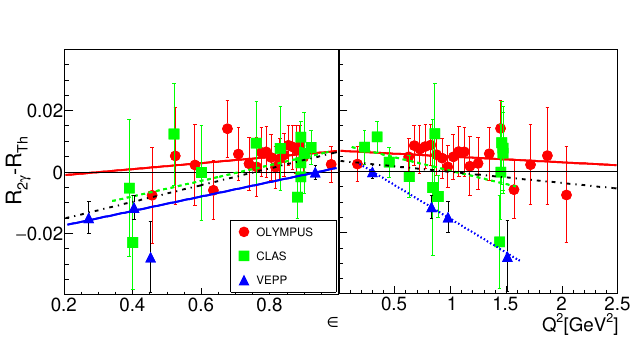
Figure 3. Point to point di ff erence between the calculation from Eq. (7), [38] and the data for the ratio R , with the corresponding linear fits as a function of (cid:15) (left) and Q 2 (right) from OLYMPUS [36] (red circles and red solid line), CLAS [35] (green squares and green dashed line) and VEPP-3 [33] (blue triangles and blue dotted line), after removing the odd corrections as in Eq. (8) with δ M from [42]. The black dash-dotted line corresponds to the global linear fit